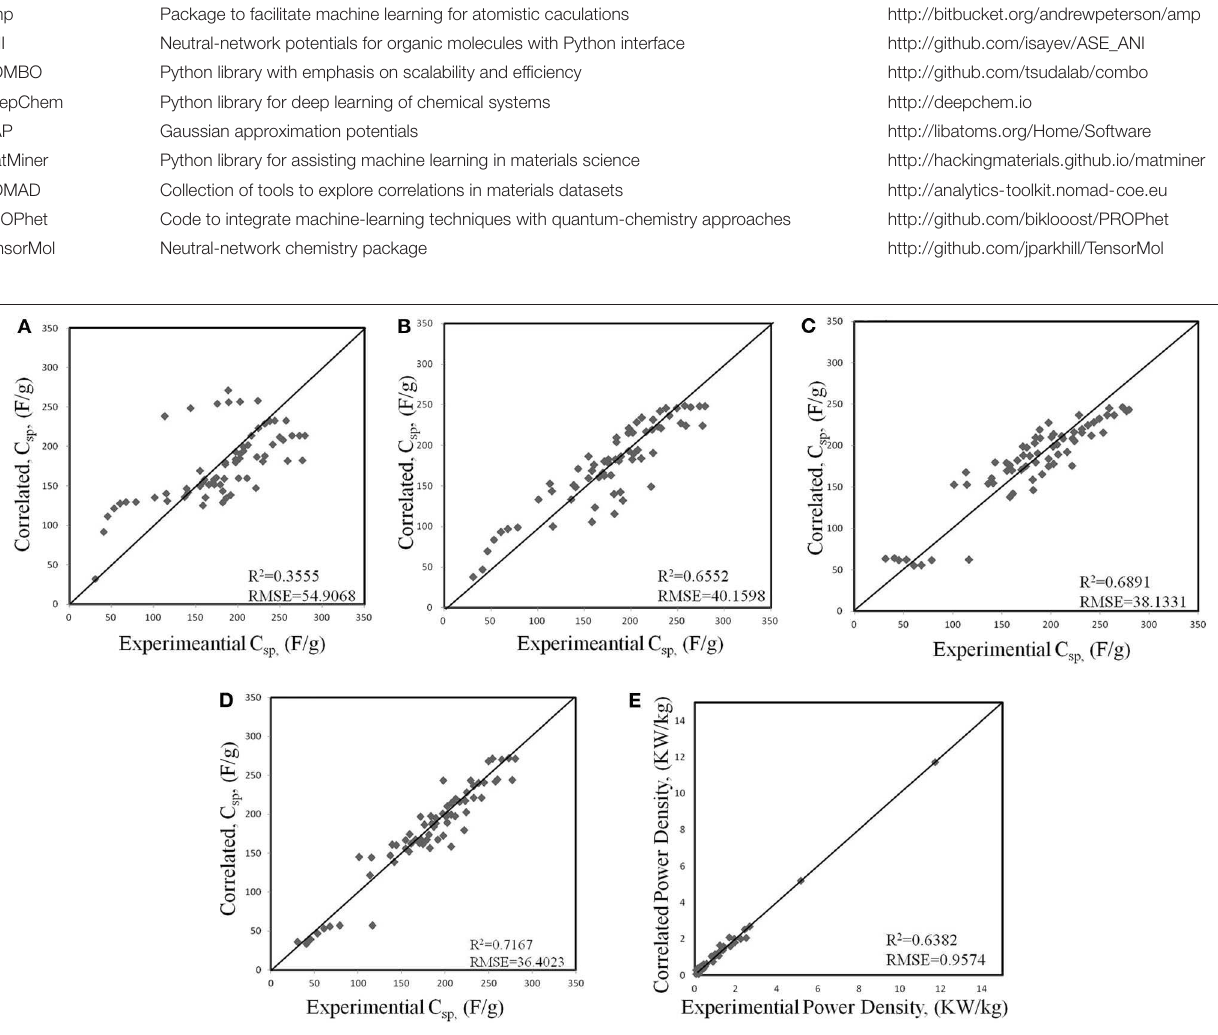
FIGURE 1 | Correlations between experimental and different ML models for the specific capacitance (C sp , F/g) of activated carbons: (A) generalized linear regression (GLR), (B) support vector machine (SVM), (C) random forest (RF), (D) artificial neural network (ANN). (E) Artificial neural network (ANN) model for correlating the power density of activated carbons. In each panel, the diagonal line represents the perfect correlation between experimental and machine-learning